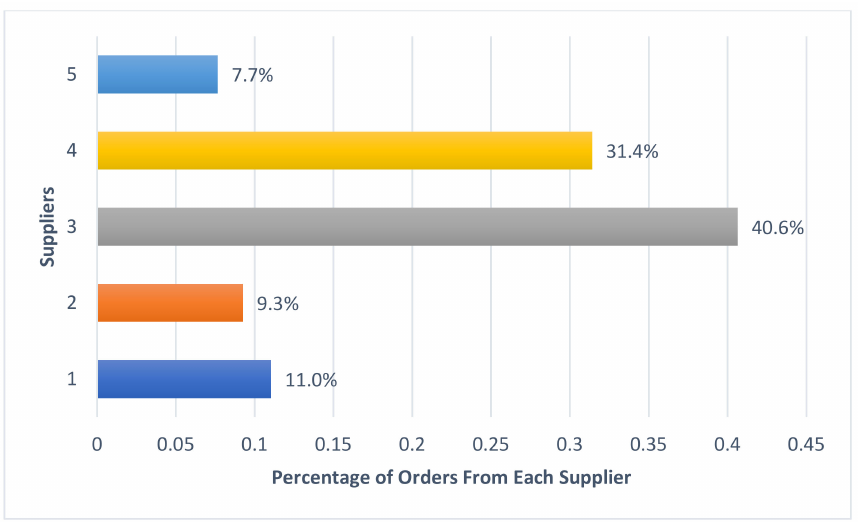
Figure 9. Optimal percentage of supplier